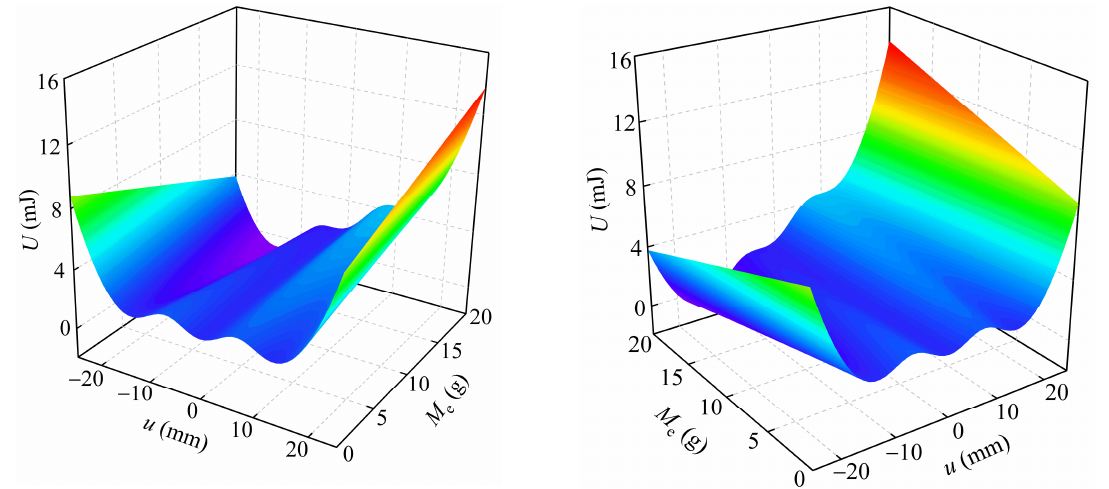
Figure 6. 3D potential energy surface of the system.